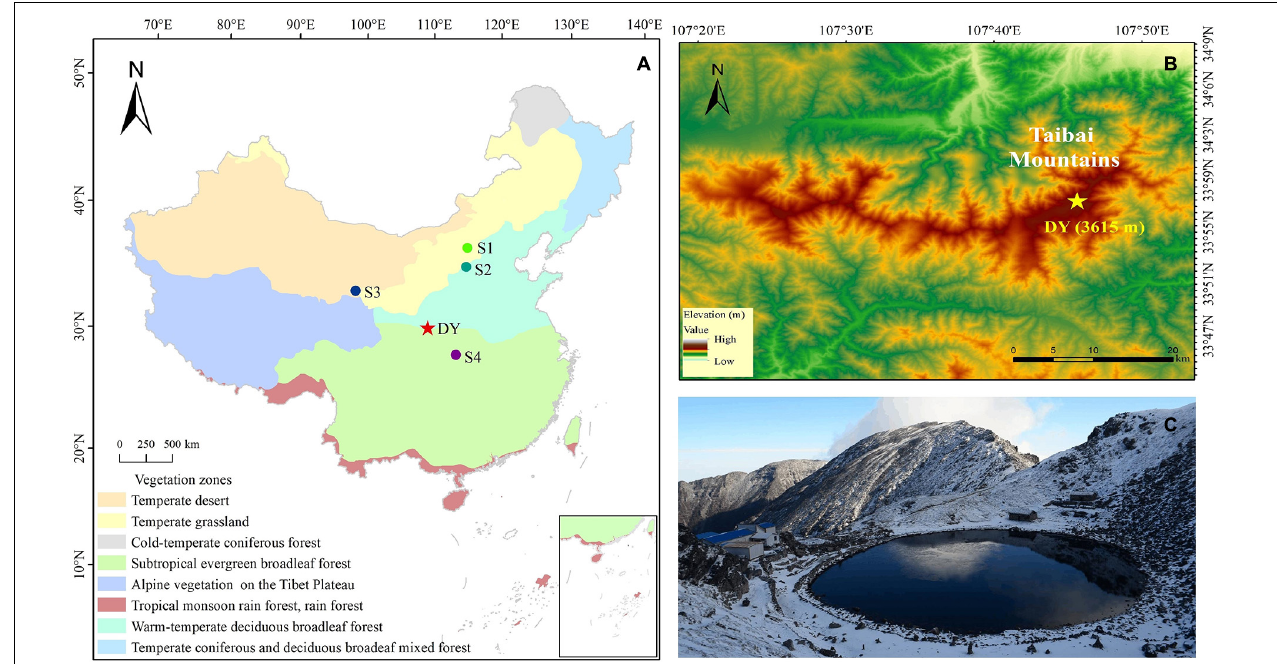
FIGURE 1 | (A) Location of the study site (DY: Daye Lake) and other sites (S1–S4) in the surrounding region that are mentioned in the text (S1: Daihai Lake; S2: Gonghai Lake; S3: Qinghai Lake; S4: Dajiuhu wetland). The vegetation zones in China (https://geodata.pku.edu.cn) are also shown; (B) digital elevation map of the study area; (C) the picture of the Daye